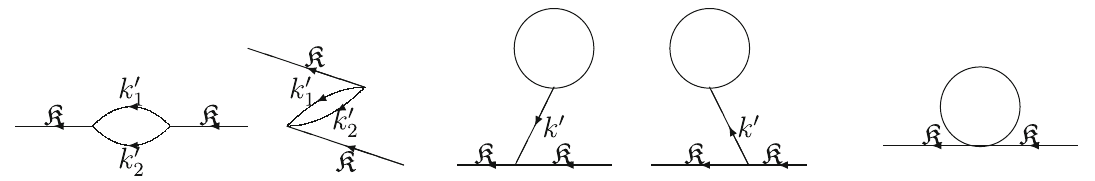
Fig. 3 The first two diagrams give the first term in μ( K ) as written in Eq. (4.12). The next two are equal and yield the second term. The last diagram corresponds to the third term. The other term may be obtained by respectively replacing one k (cid:2) in the first two diagrams with a zero